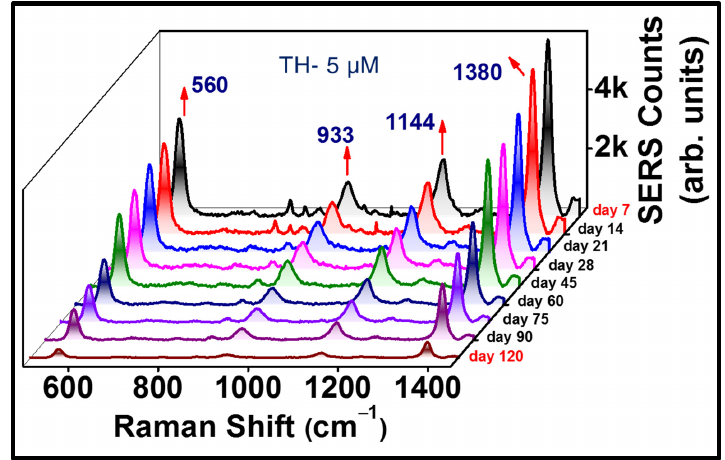
Figure 9. Stability data of AgNS2 while sensing TH (5 μ M), illustrating the significant 560 cm − 1 peak along with others. The SERS data were collected up to 120 days. Additionally, to reach a decisive conclusion about the plasmonic responses of the three Au-coated substrates (10 nm, 20 nm, and 30 nm coated AgNSs), two of the previous molecules were again detected utilizing the aforementioned coated NSs. Significantly, su- perior SERS performance is noted for all the coated AgNSs investigated, not only in terms of higher Raman peaks intensity, but also in the achievement of far better homogeneity of signal, and most importantly, detection of further lower traces. In Figure 10, we present the SERS data of TH where superior response was found with the 20 nm Au-coated AgNS, demonstrating the lowest detection limit of 50 pM (see Figure 10b). However, the 10 nm and 30 nm Au-coated NSs were able to detect only up to 5 nM, 500 pM, respectively (Fig- ure 10a,c).